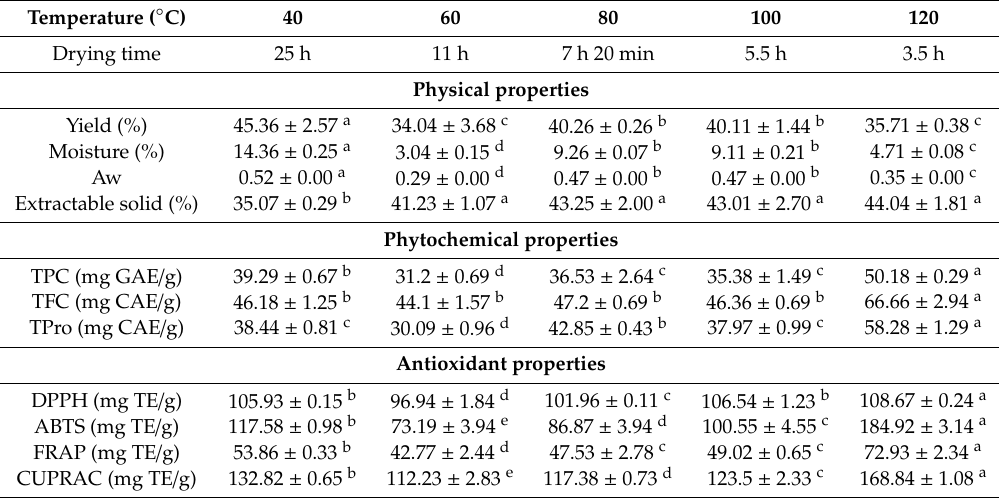
Table 3. Impact of hot air drying on physical, phytochemical and antioxidant properties of Tuckeroo fruits. Temperature ( ◦ C)